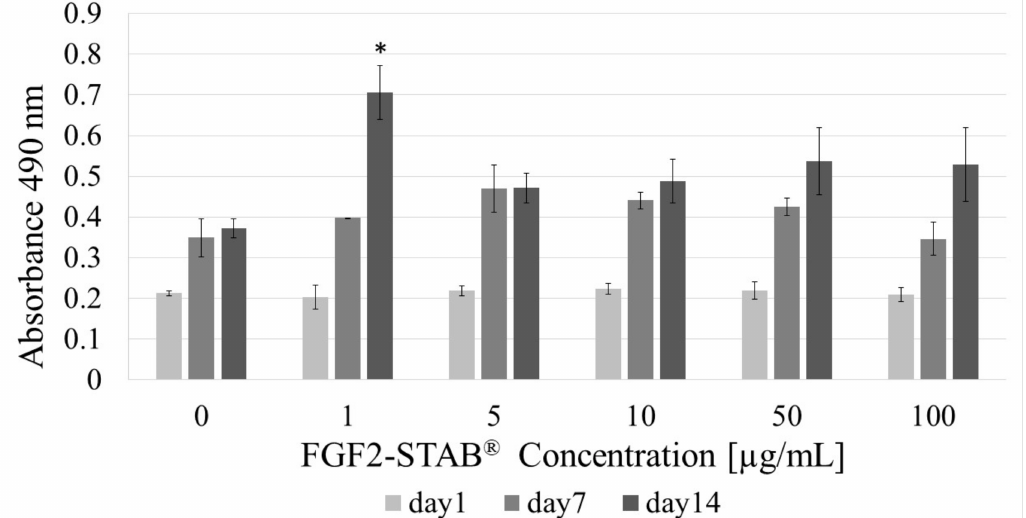
Figure 6. Fibroblast metabolic activity with increasing FGF2-STAB ® concentration (0, 1, 5, 10, 50, and 100 µ g/mL) after 1, 7 and 14 days of incubation. Statistical significance ( p < 0.05) marked with asterisk. On the 14th day the highest level was reached in the group with 1 µ g/mL of